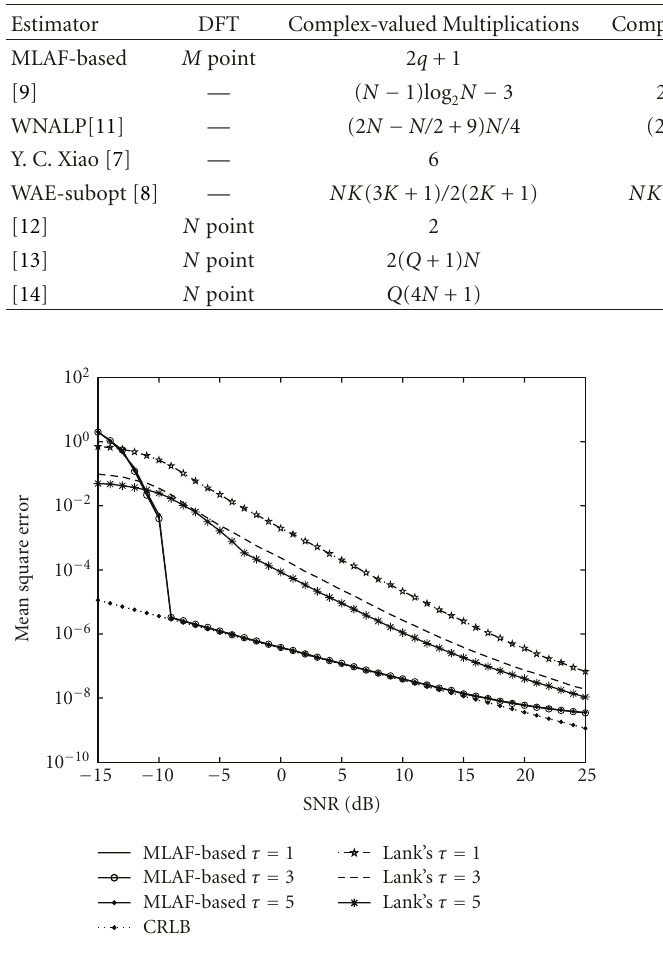
Figure 2: MSE of the MLAF-based estimator and Lank’s estimator with di ff erent τ , N = 256, q = 4. Signal frequency randomly distributes between [0, π/ 12].